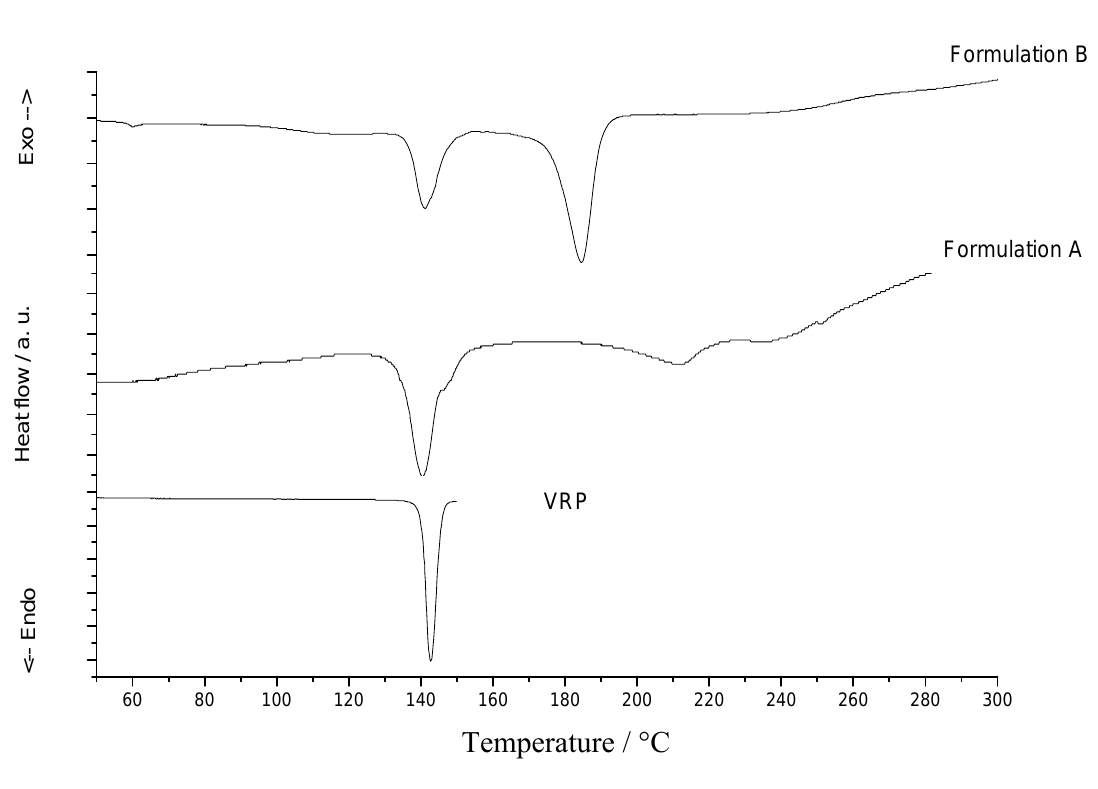
Figure 2. DSC curves of verapamil hydrochloride (VRP) from two local market formulations A and